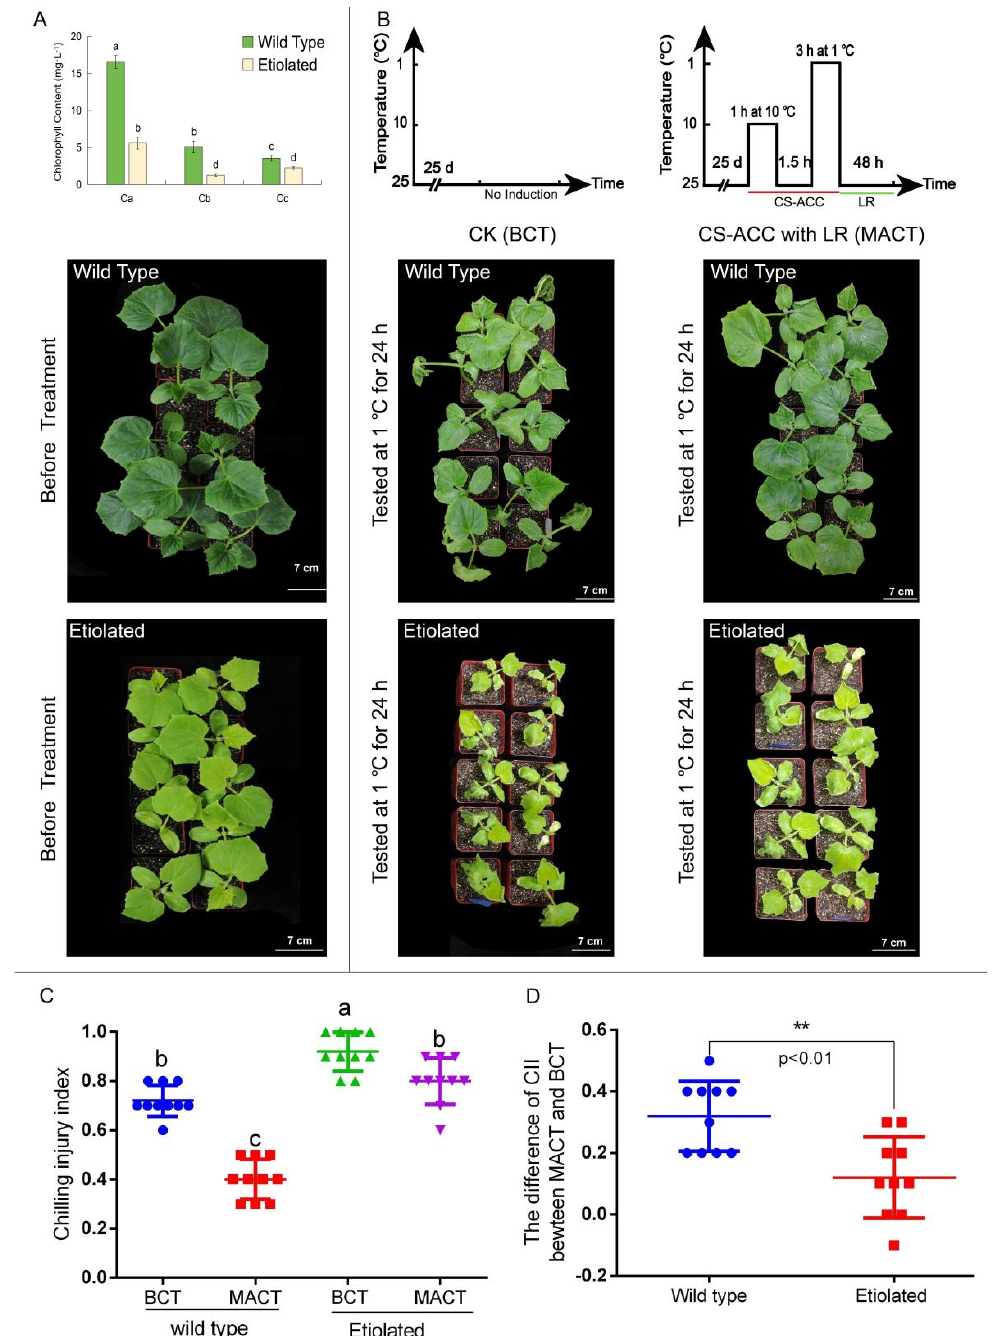
Figure 7. The photosynthetic efficiency was of vital importance to cold stress memory in cucumber seedlings. ( A ): the chlorophyll content and phenotype for the wild-type and etiolated cucumber seedlings; Ca: chlorophyll a; Cb: chlorophyll b; Cc: carotenoid. ( B ): the cold tolerance of the wild- type and etiolated cucumber seedlings after different treatments. CK: cucumber seedlings with no acclimation and at 25 °C during treatment; CS-ACC with LR: cucumber seedlings were treated with a cold stress regime of 10 °C for 1 h, 25 °C for 1.5 h, 1 °C for 3 h, and 25 °C for 48 h; CS-ACC: cold stress acclimation; LR: long recovery; BCT: basic cold stress tolerance; MACT: the maintenance of acquired cold tolerance. ( C , D ): CII of cucumber seedlings after different treatments. The different letters indicate significant differences as assessed by the Turkey HSD test ( p < 0.05; n ≥ 9). ** represents the 0.01 level.